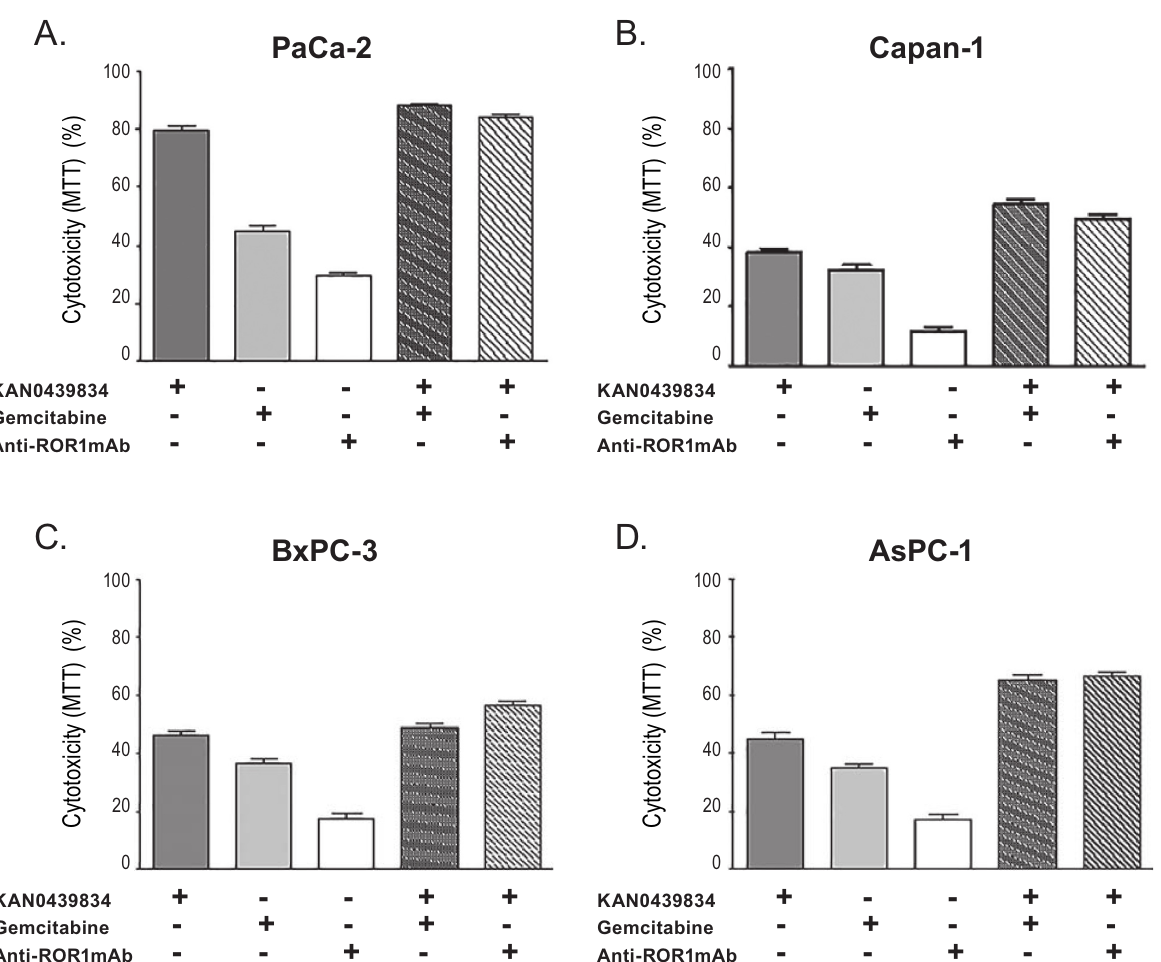
Fig 4. Cytotoxicity (MTT) (mean ± SEM) of KAN0439834, gemcitabine and anti-ROR1 mAb in pancreatic cancer cell lines. (A) KAN0439834 in PaCa-2 cell line was significantly more effective compared to gemcitabine (p = 0.0001). KAN0439834 and gemcitabine in combination induced significantly higher cytotoxicity compared to KAN0439834 or gemcitabine alone (KAN0439834 plus gemcitabine vs KAN0439834, p = 0.0033, KAN0439834 plus gemcitabine vs gemcitabine, p = 0.0001). No statistically significant difference comparing KAN0439834 with KAN0439834 plus anti-ROR1 mAb. (B) Cytotoxicity of Capan-1 cells (KAN0439834 vs gemcitabine, p = 0.0483, KAN0439834 plus gemcitabine vs KAN0439834, p = 0.0029, KAN0439834 plus gemcitabine vs gemcitabine, p = 0.0009, KAN0439834 plus anti-ROR1 CRD mAb vs KAN0439834, p = 0.0039, KAN0439834 plus anti-ROR1 mAb vs anti-ROR1 mAb, p = 0.0001) (C) Cytotoxicity of BxPC-3 cells (KAN0439834 vs gemcitabine, p = 0.0044, KAN0439834 plus gemcitabine vs KAN0439834, p = 0.1481, KAN0439834 plus gemcitabine vs gemcitabine, p = 0.0011, KAN0439834 plus